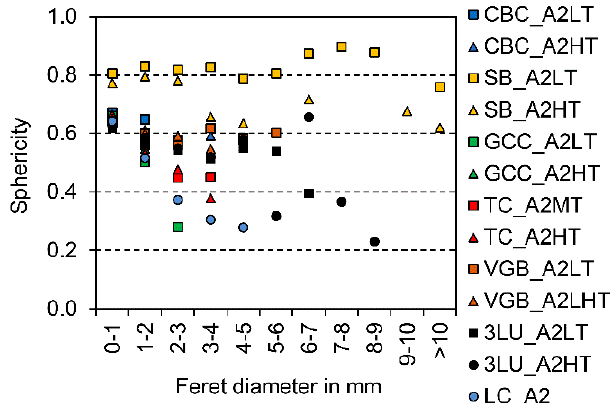
Figure 3. Filler sphericity distribution (1.0 indicates the cross section of the filler is a circle) based on one SEM-picture with max. 5100 single particles.